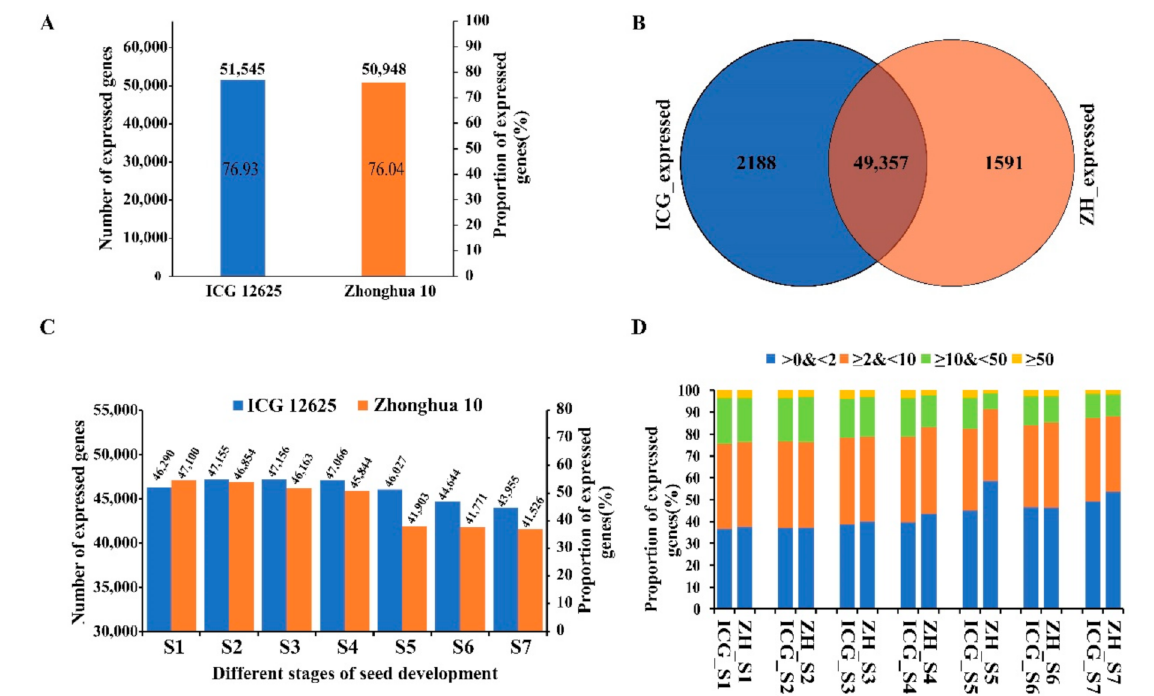
Figure 2. Gene expression levels during seed development in ICG 12625 and Zhonghua 10. ( A ) Total number and proportion of genes expressed in ICG 12625 and Zhonghua 10. ( B ) Venn diagram showed the intersection of genes expressed in ICG 12625 and Zhonghua 10. ( C ) The number and proportion of genes expressed at each stage of seed development in ICG 12625 and Zhonghua 10. ( D ) Fraction of genes expressed at different expression levels (based on FPKM) during seed development in ICG 12625 and Zhonghua